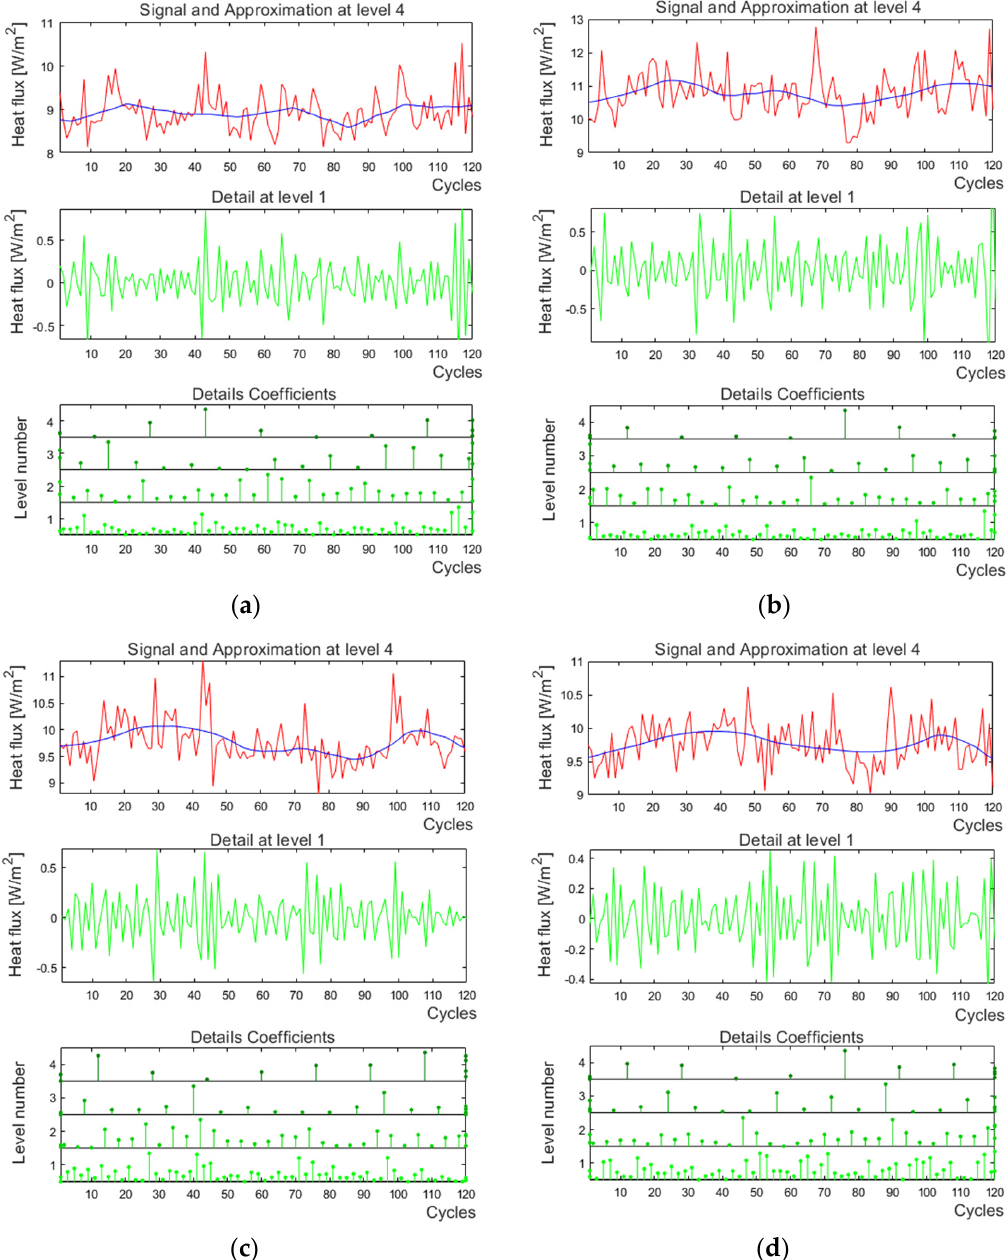
Figure 8. Decomposition of heat flux sensor signals using Daubechies 4 wavelet at decomposition level 4 for ( a ) q 9 , ( b ) q 10 , ( c ) q 11 , ( d ) q 12 .